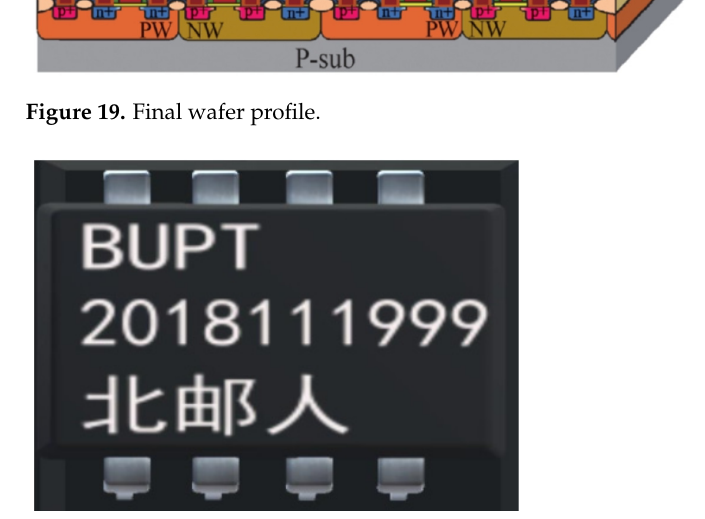
Table 6. Integrated circuit test results. Input Frequency Peak ‐ to ‐ Peak Value of Input Signal